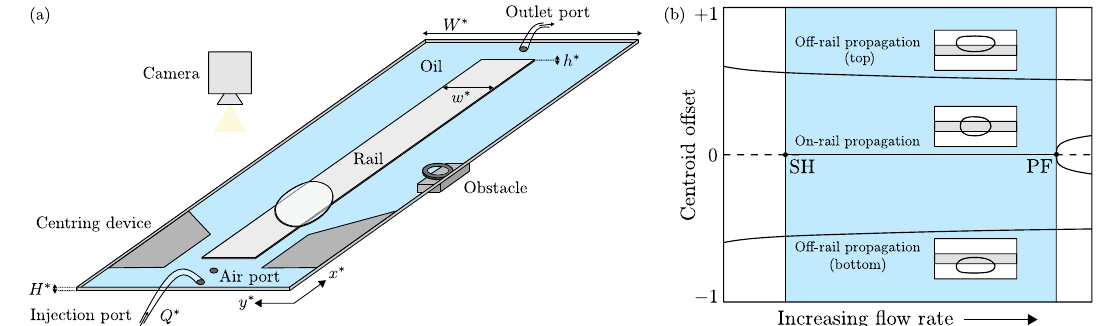
Figure 1. ( a ) Schematic view of the experimental Hele–Shaw channel, which features an axial-centred elevation, or rail, along its length. An obstacle is placed downstream of the centring device, in contact with one of the channel side-walls, resulting in a local constriction of the channel width. ( b ) Schematic of the system’s underlying steady state space with variation of the driving flow rate. Each state is characterised by the normalised lateral offset of the bubble centroid from the channel centreline. The shaded region of interest is bounded between a subcritical Hopf bifurcation (SH) and a supercritical pitchfork bifurcation (PF). Within this region, there are three stable states available to the initial bubble: steady on-rail propagation about the channel centreline and steady off-rail propagation, in which the lateral placement of the bubble is biased towards one of the channel side-walls. Snapshots of the states are shown in the associated